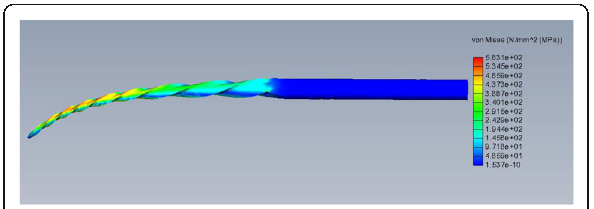
Fig. 6 Stress distribution during bending of WaveOne